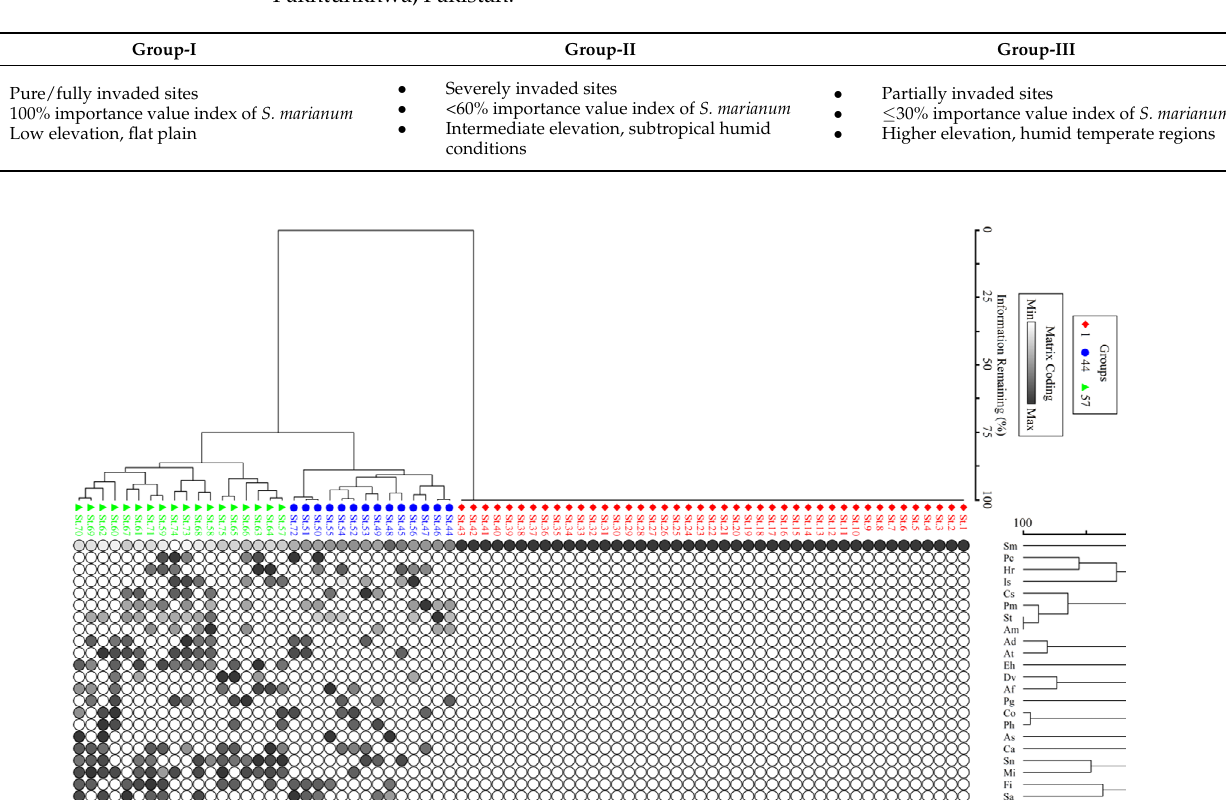
Table 1. Site conditions of Silybum marianum sampling areas distributed in Khyber Pakhtunkhwa,